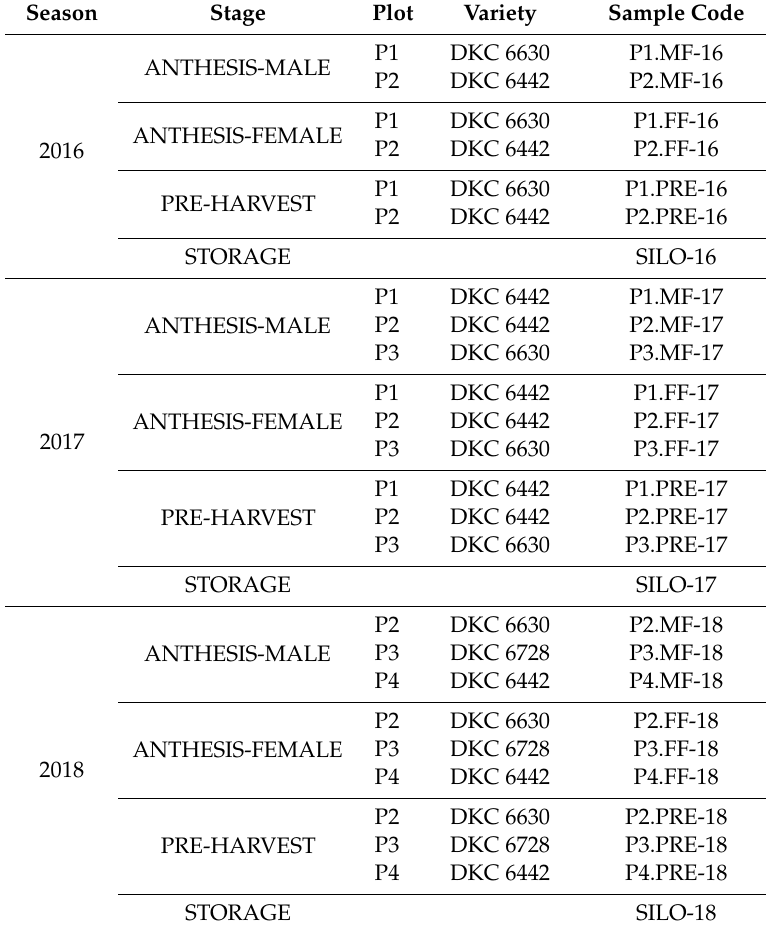
Table 1. Characteristics of maize samples analyzed in this study, obtained from three growth stages during three consecutive